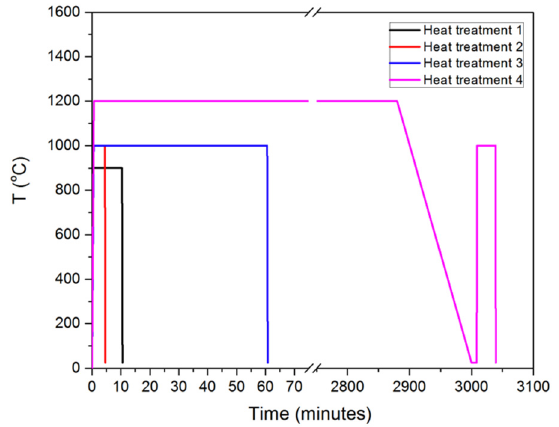
Figure 1. Heat treatment operations that were applied to obtain fully martensitic steels with various prior austenite grain sizes.